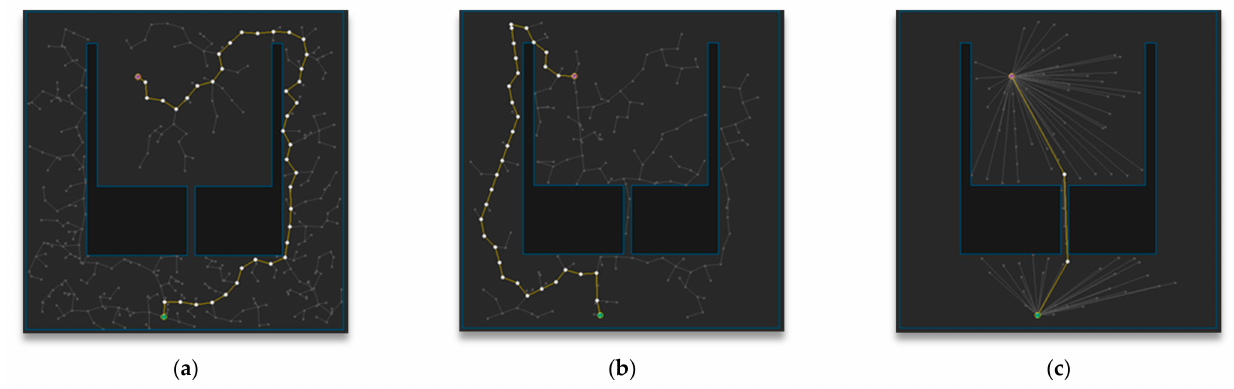
Figure 17. Experimental result of Map 7: ( a ) RRT; ( b ) RRT-Connect; ( c ) the proposed algorithm.